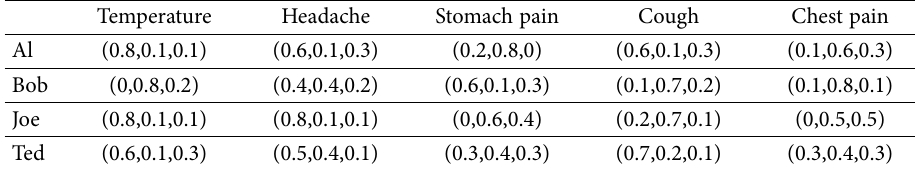
Table 6. Symptoms characteristic for the considered patients